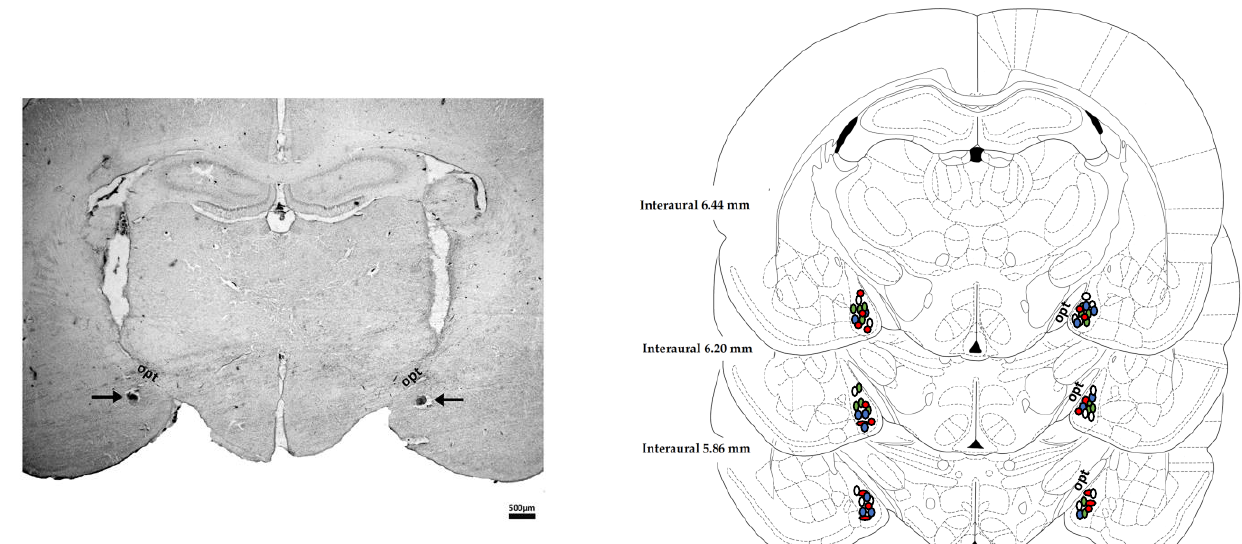
Figure 1. Microinjection sites into the MeA. ( Left ) Photomicrograph of a coronal brain section illustrating bilateral injection sites in the medial amygdaloid nucleus (MeA) of a representative animal. ( Right ) Diagrammatic representation based on Paxinos & Watson [40] showing the microinjection sites in the medial amygdaloid nucleus (MeA) of the selective AT 1 receptor antagonist losartan (red circles), the selective MAS receptor antagonist A-779 (blue circles), the selective AT 2 receptor antagonist PD123319 (green circles) and vehicle (white circles). The number shown in the figure can be smaller than the total number of animals used in this experiment due to the overlap of some injection sites. Opt—optical tract.